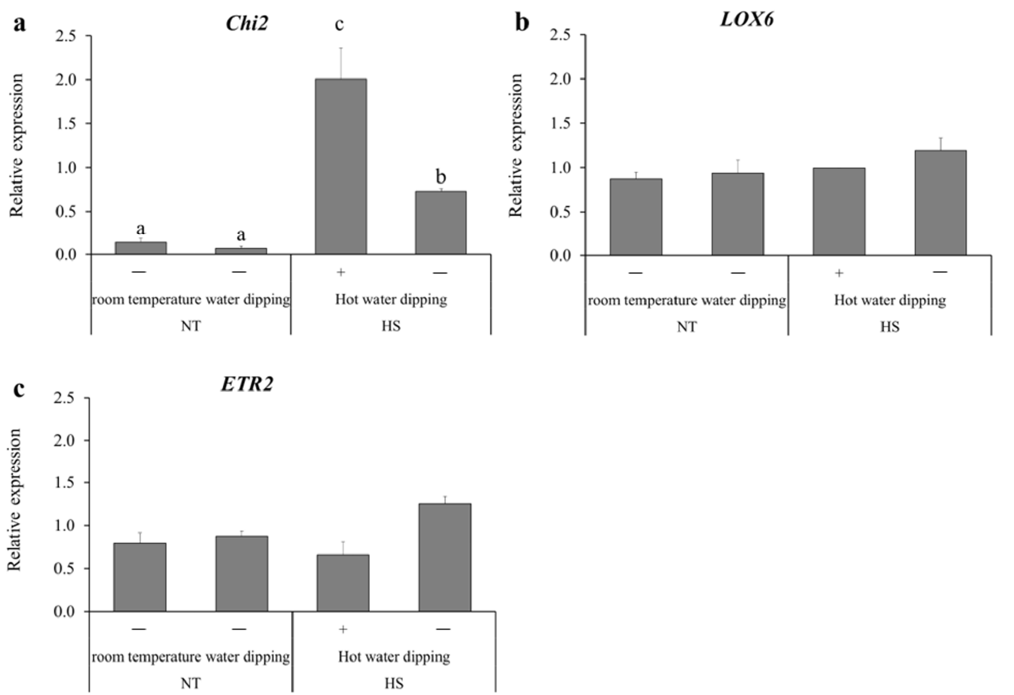
Figure 4. Relative expression levels of Chi2 , ETR2 , and LOX6 in cucumber leaves after partial heat shock (HS) treatment. ( a ) Chi2 , ( b ) LOX6 , ( c ) ETR2 . NT: non-treatment. +: One of two leaves dipped into hot water at 50 °C for 20 s. − : leaves not treated with heat shock. Different letters above columns indicate a significant difference between treatments. Vertical bars represent the standard error of the mean ( n = 6). The transcript levels of each gene are normalized to Act expression.